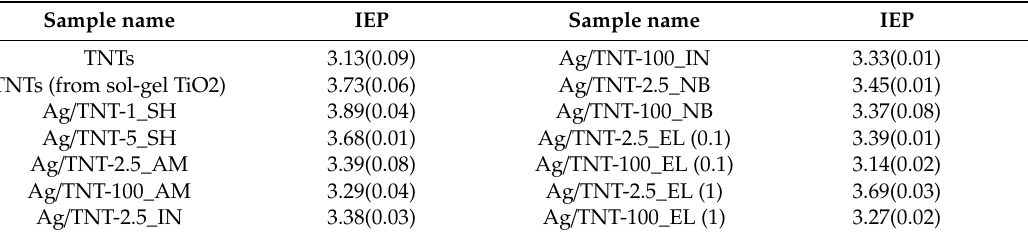
Table 4. The isoelectric point (IEP) of the TNTs and Ag /